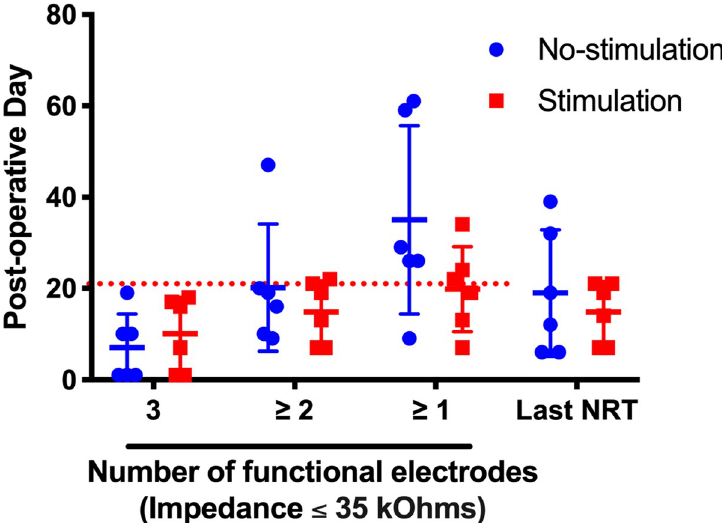
Fig 5. Impedance and NRT over time. Mean and individual duration of electrode functionality (impedance � 35 kOhms) and time of last obtainable NRT recording. The left side of the figure portrays the duration that each implant maintained the respective number of functioning electrodes. The right side of the figure portrays the last timepoint at which an NRT response could be obtained for each implant. Non-stimulated subjects are represented by blue circles and stimulated subjects by red squares. Horizontal bars represent mean group values. The red, dotted line marks the 21 day experimental endpoint threshold. 5/6 and 3/6 subjects in the no-stimulation and stimulation groups met or surpassed the 21 day threshold of maintaining at least one functional electrode, respectively. NRT responses were generally obtainable while at least 2 electrodes maintained impedance levels � 35 kOhms. Error bars represent Standard